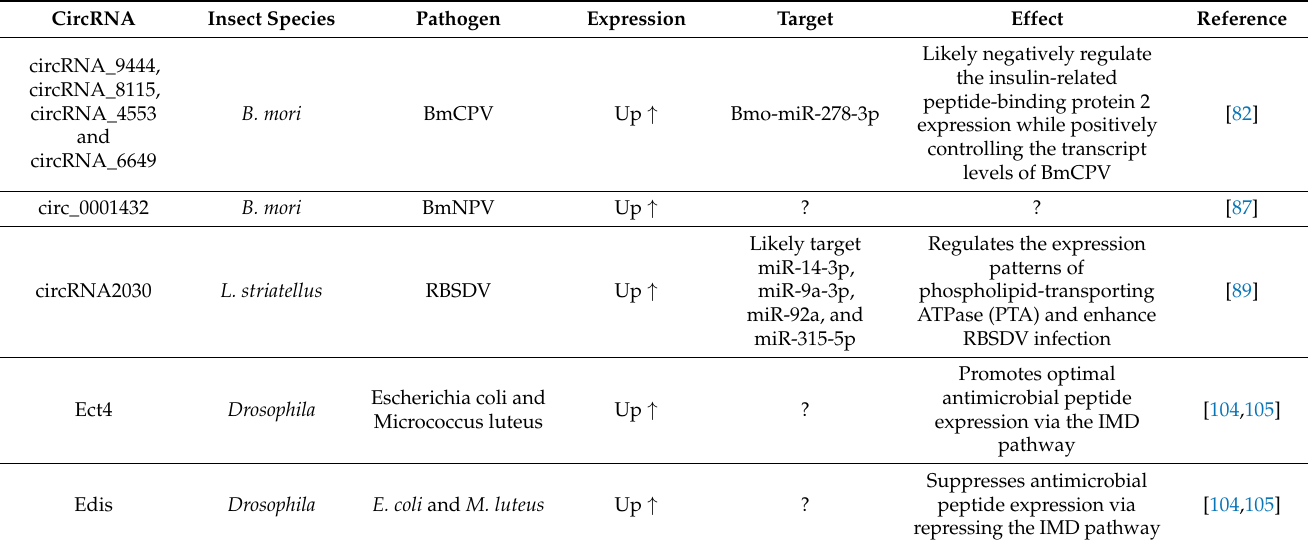
Table 1. Circular RNAs involved in the immune responses of insects to microbial